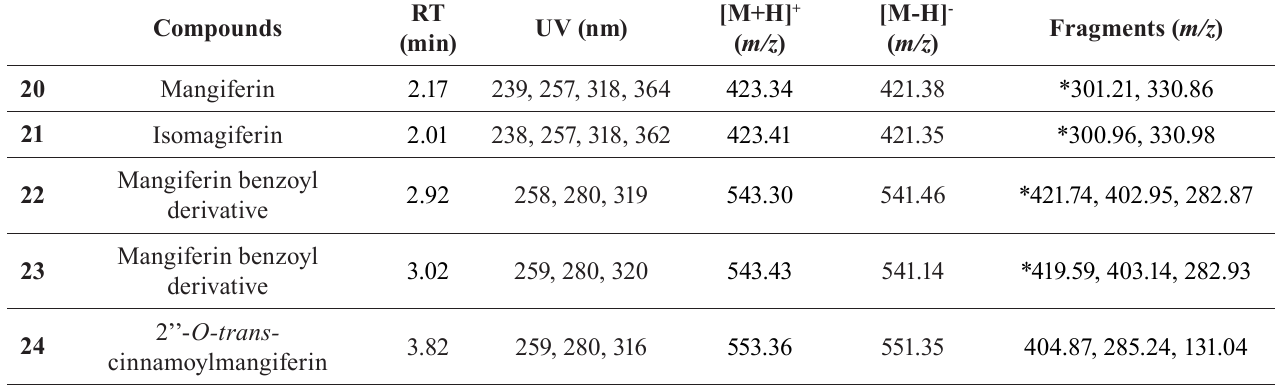
TABLE II - Xanthones identified in ethanolic extract of leaves from the Fridericia samydoides negative ion mode